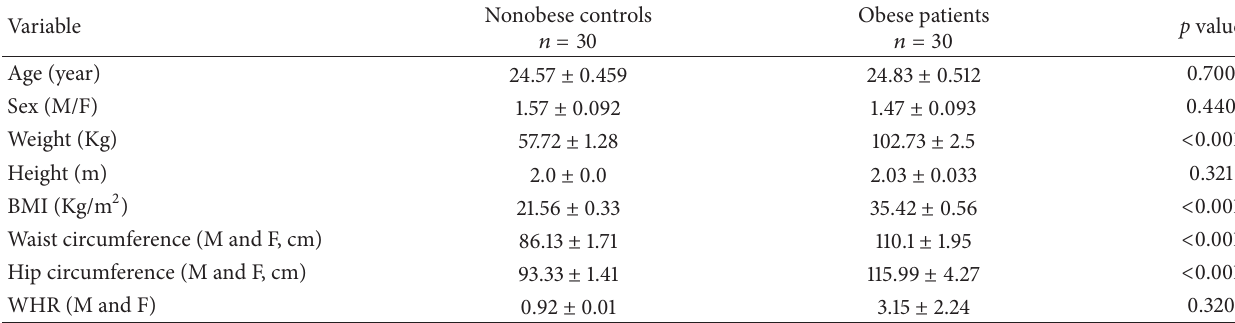
Table 1: Characteristics of patients and subjects of the current